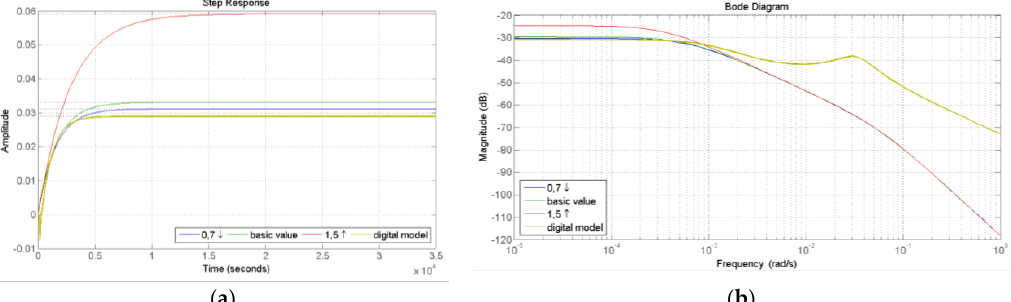
Figure 5. Segment G1 step ( a ) and frequency responses ( b ) for simulation of changes in working medium flow rate. Processes 2020 , 8 , x FOR PEER REVIEW